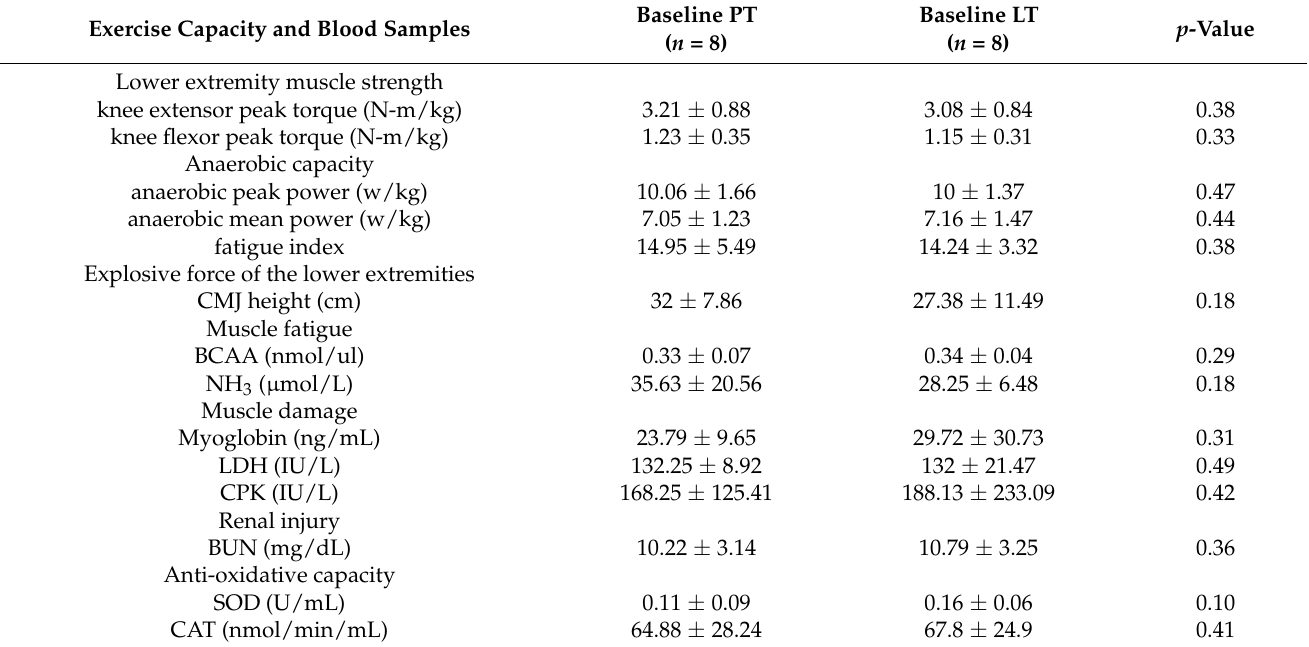
Table 1. Test of homogeneity.